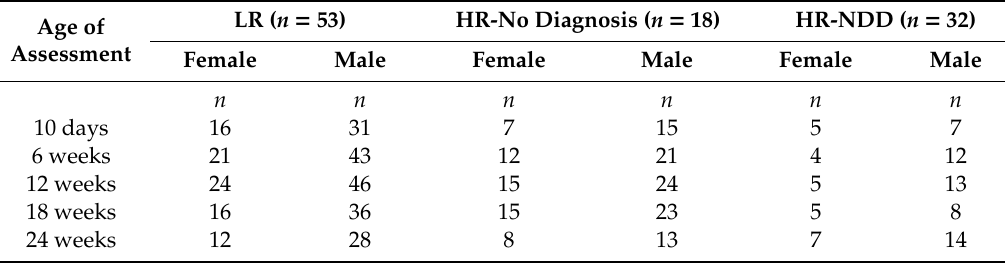
Table 1. Video recordings available at various ages of